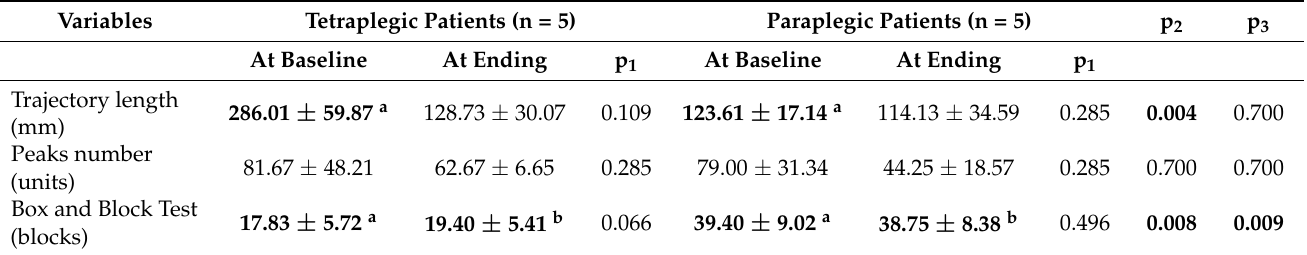
Table 2. Performance in relation to the trajectory, peaks number and the Box and Block test at baseline and at ending the upper extremity training for tetraplegic and paraplegic patients.